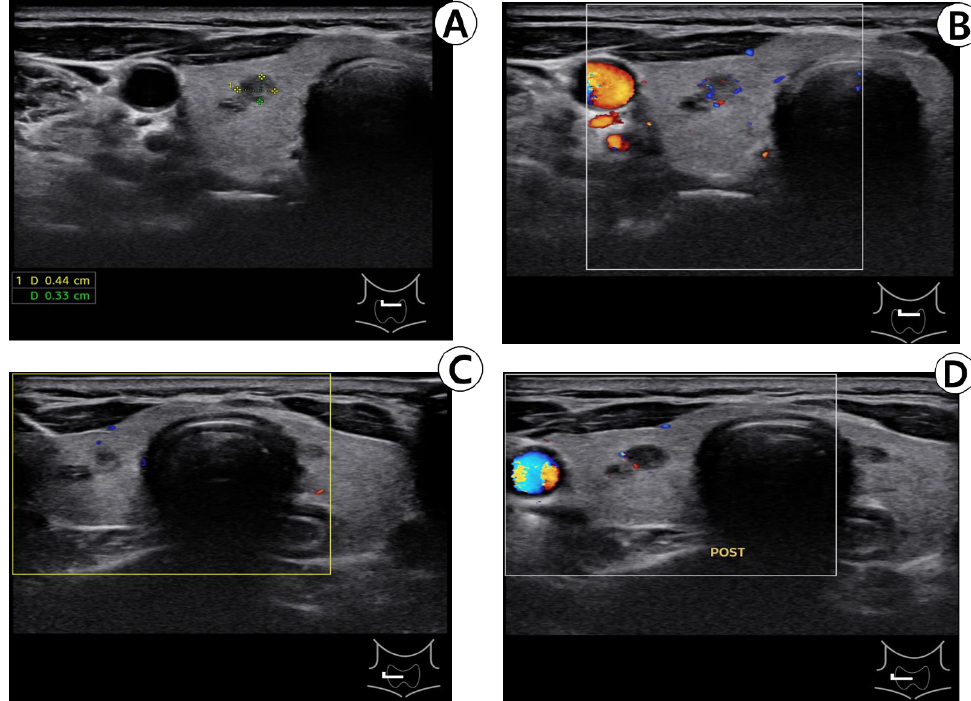
Figure 1. Ultrasonography (US) of the thyroid before ( A , B ) and after ( C , D ) fine-needle aspiration (FNA). ( A ) US before FNA, revealing a solid and hypoechoic nodule in the right lobe. ( B ) Color- Doppler US revealing a solid, hypoechoic nodule without increase in vascularity that could cause potential bleeding during FNA. ( C , D ) On immediate US after biopsy, there was no evidence of post-biopsy